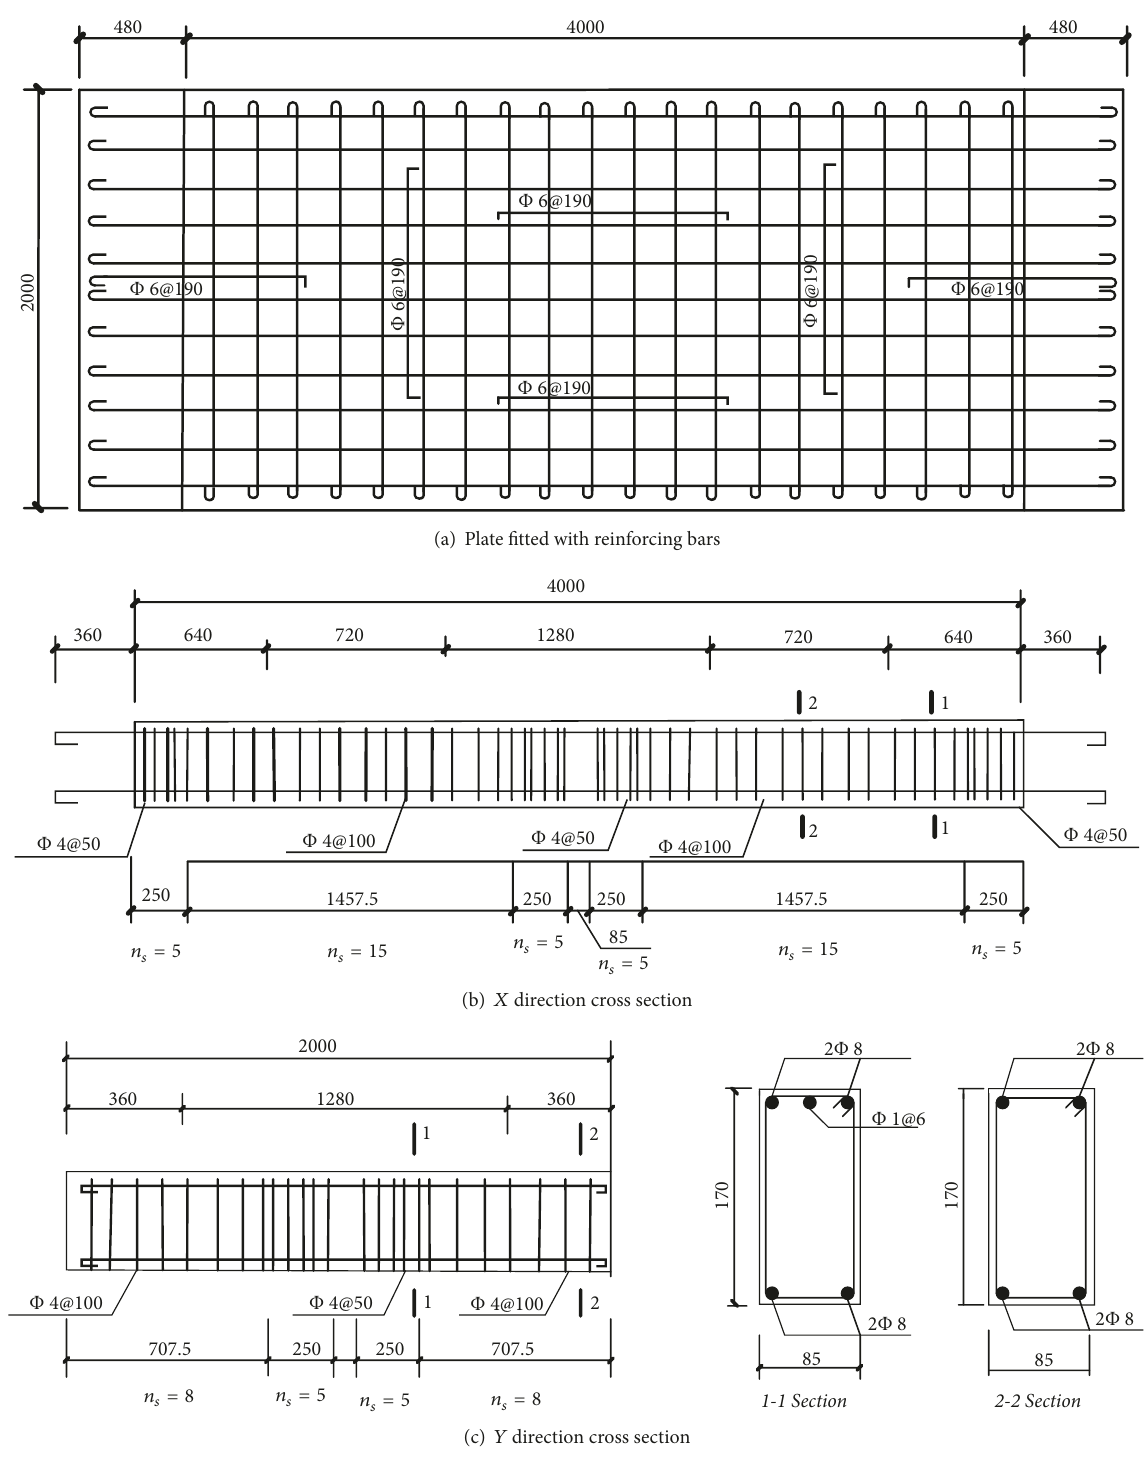
Figure 6: Reinforce details of the RC